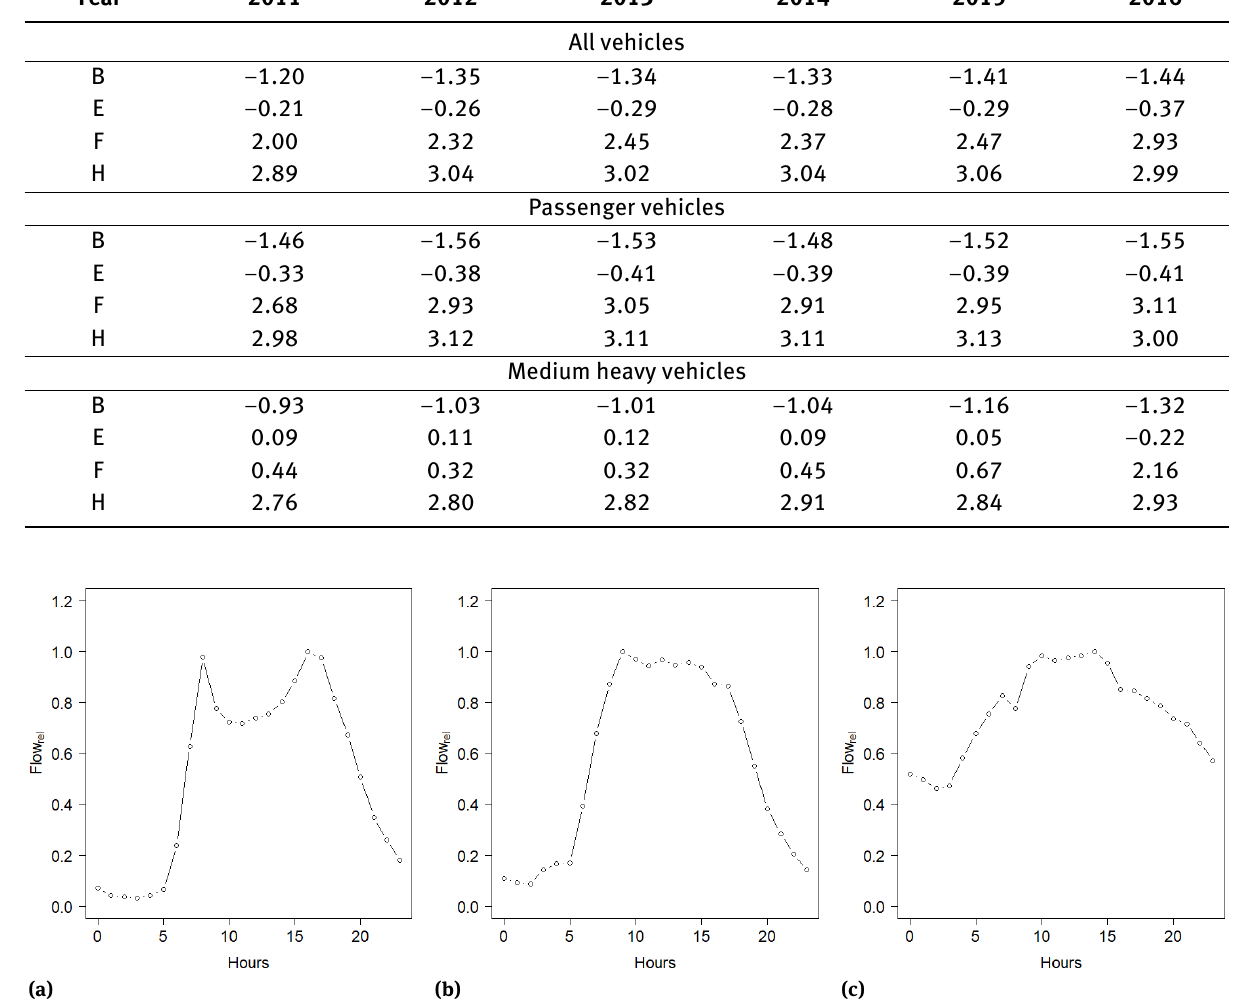
Figure 10: Relation between the normalized annual hourly traflc flow and time at business days in 2012 for a) passenger vehicles, b) medium heavy vehicles c) heavy